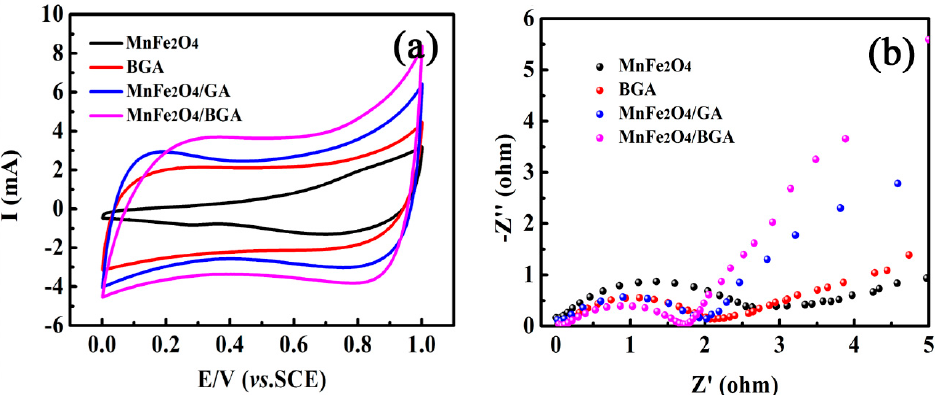
Figure 14. ( a ) CV curves and ( b ) EIS spectra of MnFe 2 O 4 , BGA, MnFe 2 O 4 /GA, and MnFe 2 O 4 /BGA.